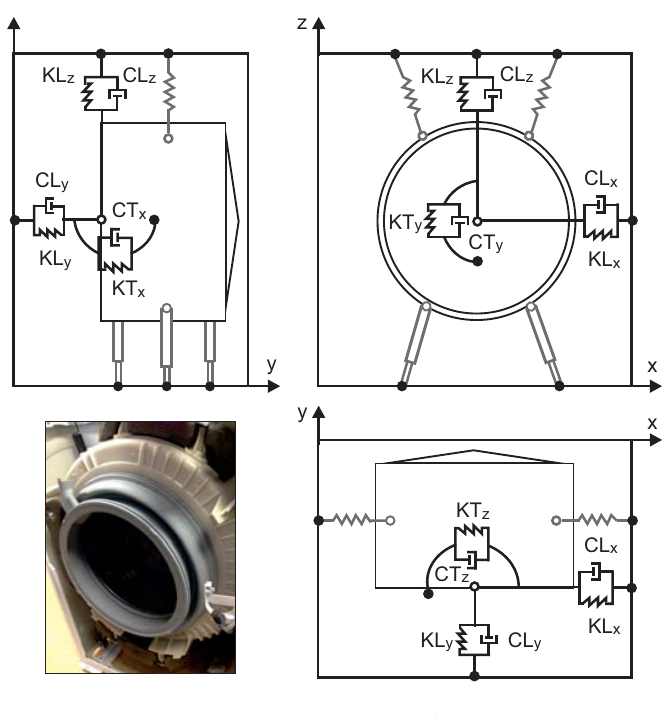
Figure 4. Gasket